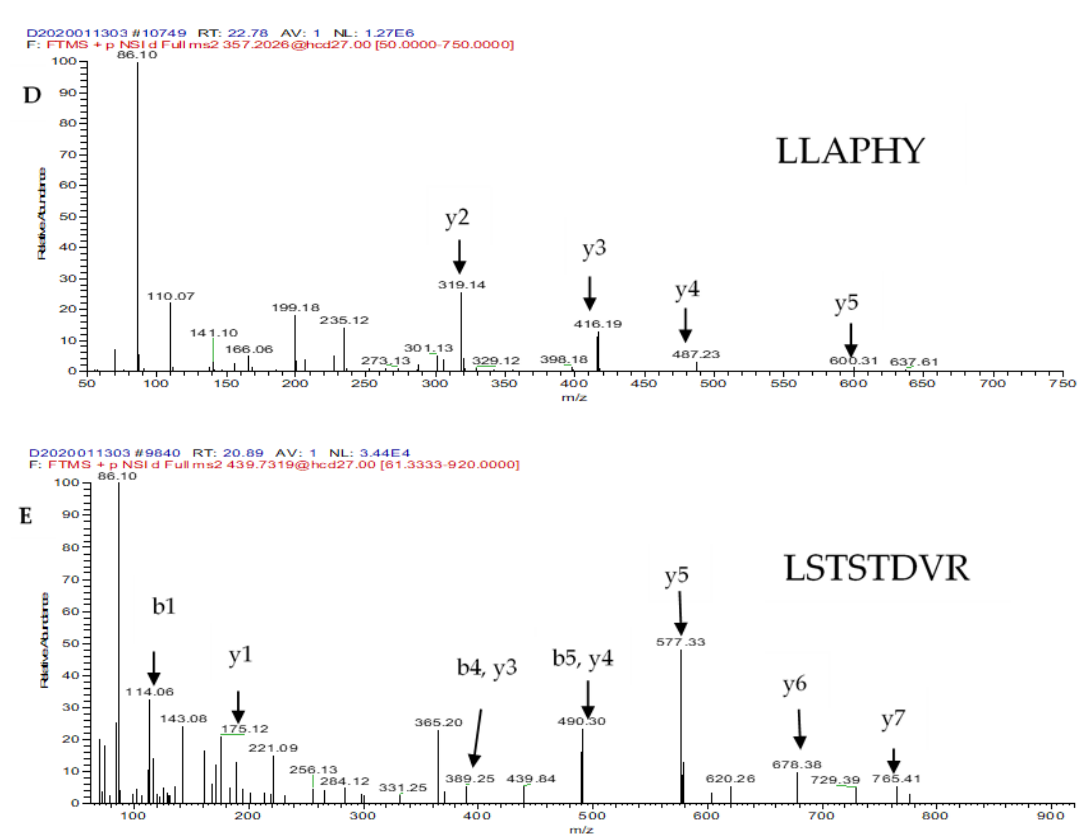
Figure 4. LC-MS chromatogram of HILIC-FT / RP-F8: ( A ) Full LC-MS chromatogram, ( B ) ALVY; MS / MS spectrum at m / z 465, ( C ) LLVY; MS / MS spectrum at m / z 507, ( D ) LLAPHY; MS / MS spectrum at m / z 357.43066 and ( E ) LSTSTDVR; MS / MS spectrum at m / z 439. All MS / MS spectra were performed under positive mode. Table 1. Identification and bioactivity of peptides from flow through RP-HPLC fraction